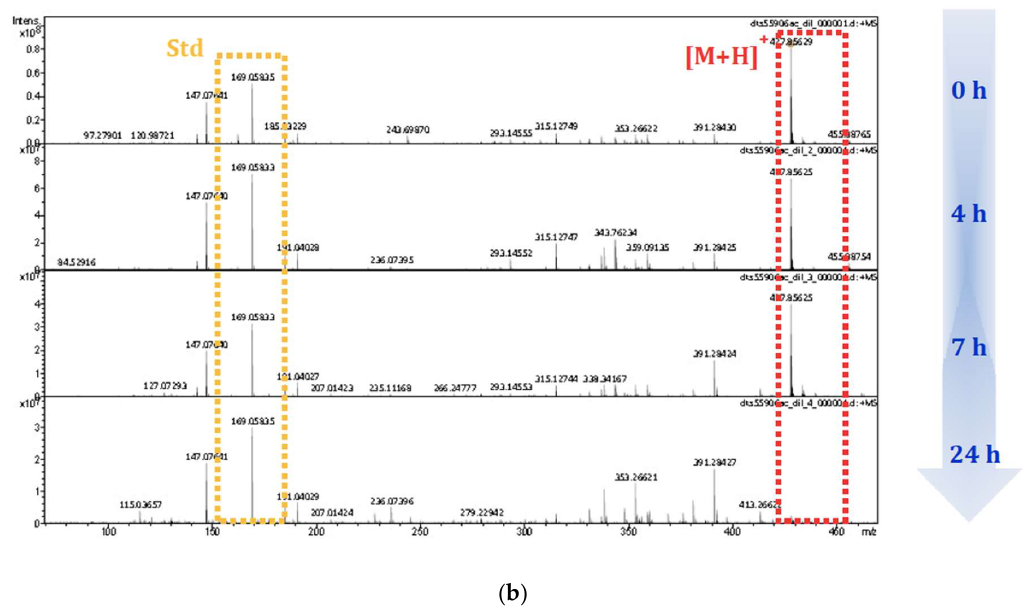
Figure A2. Electron spray mass spectra for the degradation of L-G 1 ( a ) and L-G 2 ( b ) self-assembled dendrimers dissolved in ammonium bicarbonate at pH = 7.4 TEM images of worm-like micelles of L-G 1 bound to heparin, scale bar = 100 nm. On drying, the worm-like micelle-heparin complex hierarchically assembles into larger aggregates. Worm like micelles can most clearly be visualized curved into ‘U shapes’ in the lower aggregates—multiple cylindrical micelles appear to be packed together in these regions. ( b ) TEM images of spherical micelles of L-G 2 bound to heparin, scale bar = 50 nm. Some free micelles can be seen within the image, but most have further aggregated hierarchically on binding to heparin and drying to yield a nanostructure which in this case is ca. 50 nm in diameter. Adapted from [26] with the permission of The Royal Society of Chemistry.